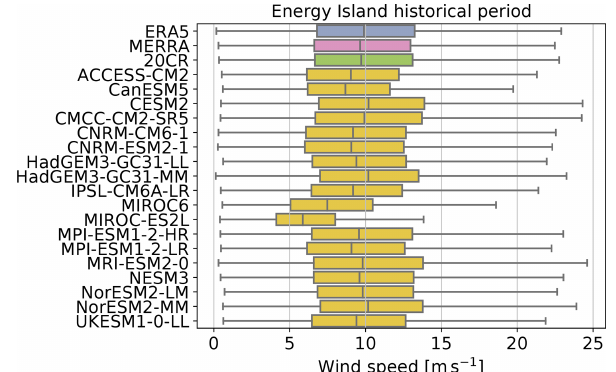
Figure 3. Comparison of the wind speed at 100ma.g.l. simulated by the CMIP6 models (see Table 1) and that provided by global re- analyses during the full historical period (1980–2014) for the En- ergy Island. The 6-hourly data from each CMIP6 model is syn- chronized with the ERA5 reanalysis. The boxplots show the “min- imum”, first quartile (Q1), median, third quartile (Q3), and “maxi- mum” of each